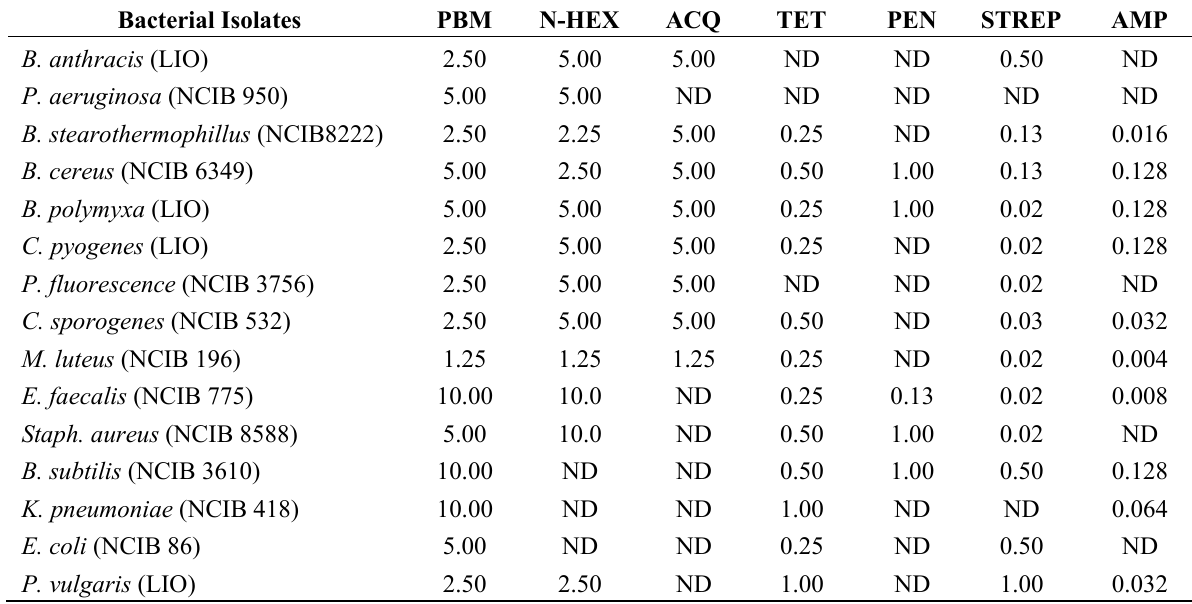
Table 5. The minimum bactericidal concentrations (mg/mL) of the extract, n -hexane and aqueous fractions and standard antibiotics against bacterial